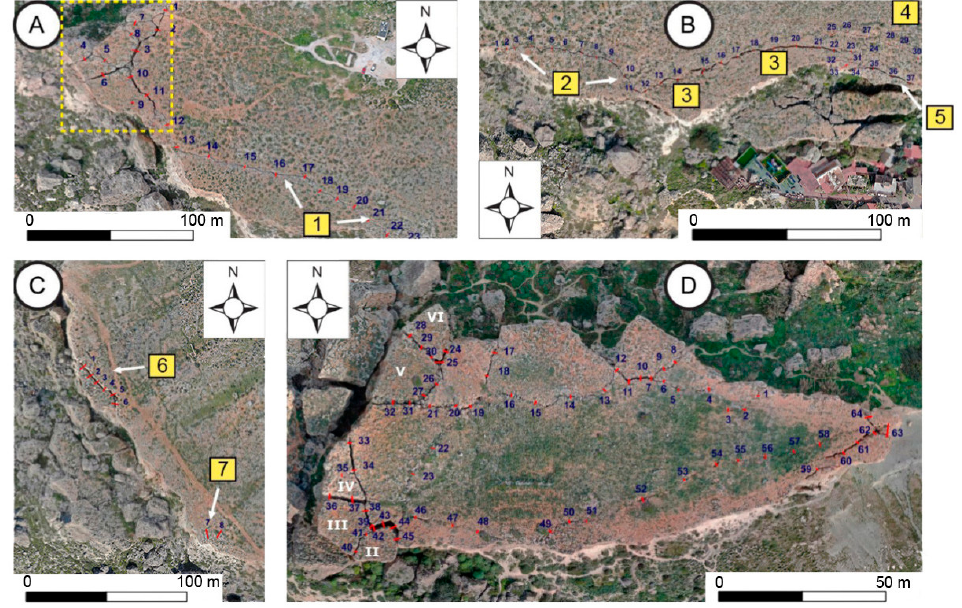
Figure 9. Joint maps obtained by 3D-model analyses of: ( A ) Marfa Ridge; ( B ) Anchor Bay; ( C ) Ras Il-Wahx; and ( D ) Il-Qarraba. Numbers inside yellow squares indicate single points. The purple numbers located along the joints approximately indicate the locations where aperture observations were performed using 3D models.